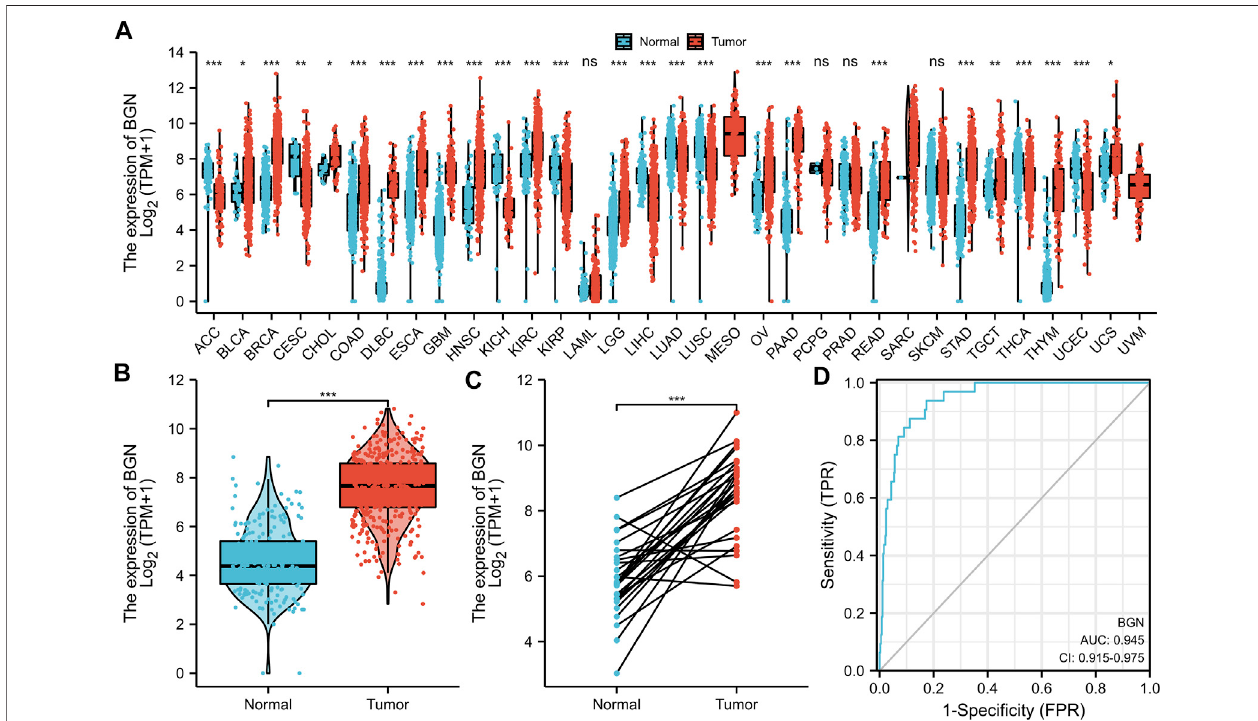
FIGURE1| DifferentialexpressionofBGNindifferenttumorsandBGN-relateddifferentiallyexpressedgenes(DEGs). (A) DifferentialexpressionofBGNofdifferent cancers compared with normal tissues in the TCGA and GTEx database. (B,C) Differential expression of BGN in STAD. (D) ROC curve was used to calculate the diagnostic predictive value of BGN expression between STAD and normal tissues. Signi fi cance marker: ns, p ≥ 0.05; *, p < 0.05; **, p < 0.01; ***, p < 0.001. The abbreviations for 33 cancers are as follows: Adrenocortical carcinoma (ACC); Bladder Urothelial Carcinoma (BLCA); Breast invasive carcinoma (BRCA); Cervical squamouscellcarcinomaandendocervicaladenocarcinoma(CESC);Cholangiocarcinoma(CHOL);Colonadenocarcinoma(COAD);LymphoidNeoplasmDiffuseLarge B-cell Lymphoma (DLBC); Esophageal carcinoma (ESCA); Glioblastoma multiforme (GBM); Head and Neck squamous cell carcinoma (HNSC); Kidney Chromophobe (KICH); Kidney renal clear cell carcinoma (KIRC); Kidney renal papillary cell carcinoma (KIRP); Acute Myeloid Leukemia (LAML); Brain Lower Grade Glioma (LGG); Liver hepatocellular carcinoma (LIHC); Lung adenocarcinoma (LUAD); Mesothelioma (MESO); Ovarian serous cystadenocarcinoma (OV); Pancreatic adenocarcinoma (PAAD); Pheochromocytoma and Paraganglioma (PCPG); Prostate adenocarcinoma (PRAD); Rectum adenocarcinoma (READ); Sarcoma (SARC); Skin Cutaneous Melanoma (SKCM); Testicular Germ Cell Tumors (TGCT); Thyroid carcinoma (THCA); Thymoma (THYM); Uterine Corpus Endometrial Carcinoma (UCEC); Uterine Carcinosarcoma (UCS); Uveal Melanoma